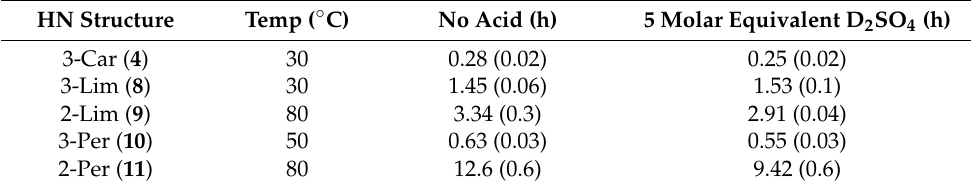
Table 1. Lifetimes (hours) of HN conversion in 25% D 2 O/DMSO- d 6 with and without the addition of 5 molar equivalents of D 2 SO 4 . Uncertainties, given in parentheses, represent one standard deviation from triplicate